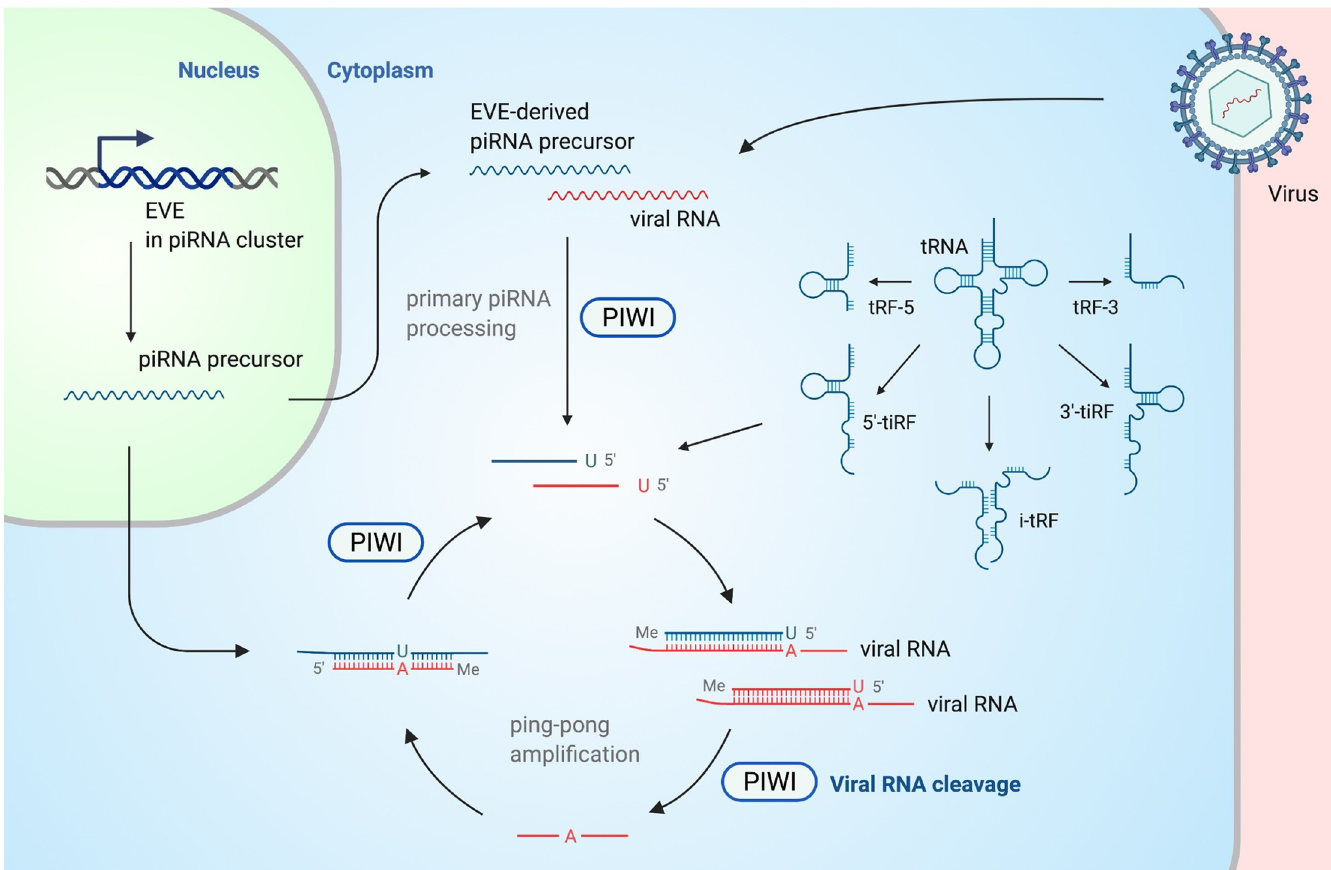
Fig 2. Overview of antiviral piRNA pathway and antiviral tRFs. piRNAs with antiviral potential can be generated via several mechanisms: primary processing of piRNA cluster transcripts that contain an EVE, direct non-piRNA guided cleavage of viral RNA via a Piwi protein (vpiRNA), EVE-derived piRNA- or vpiRNA-guided cleavage of viral RNAs via a ping-pong amplification loop, or PIWI interactions with virus-homologous noncanonical piRNAs such as tRFs. EVE, endogenous viral element; piRNA, PIWI-interacting RNA; tRF, tRNA fragment; vpiRNA, virus-specific PIWI-interacting RNA.